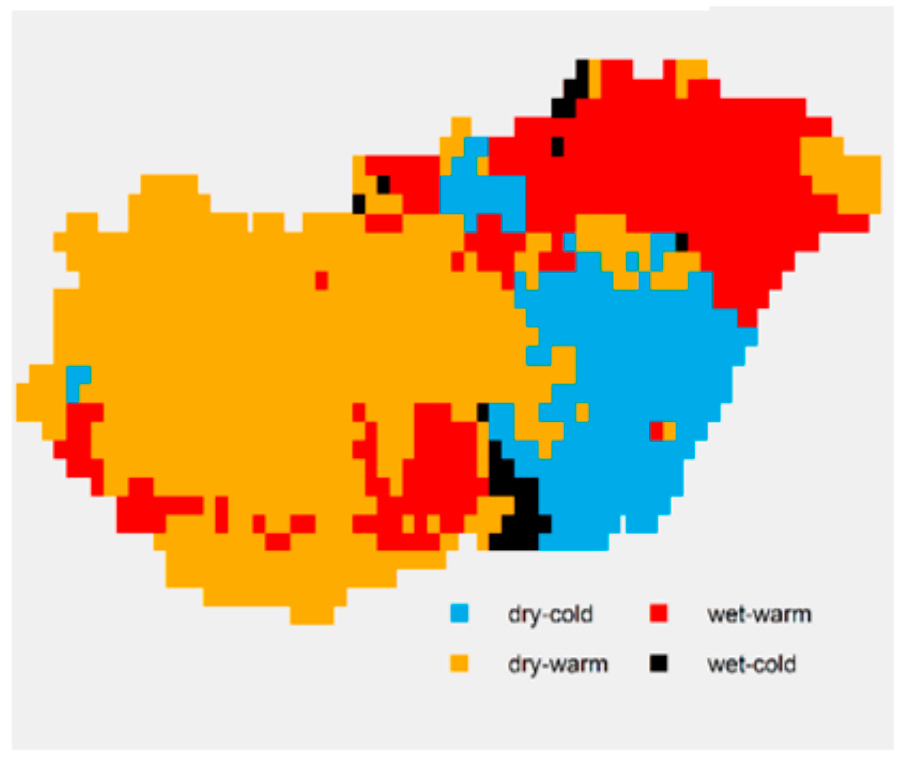
Figure A8. Characteristics of extreme months (May).